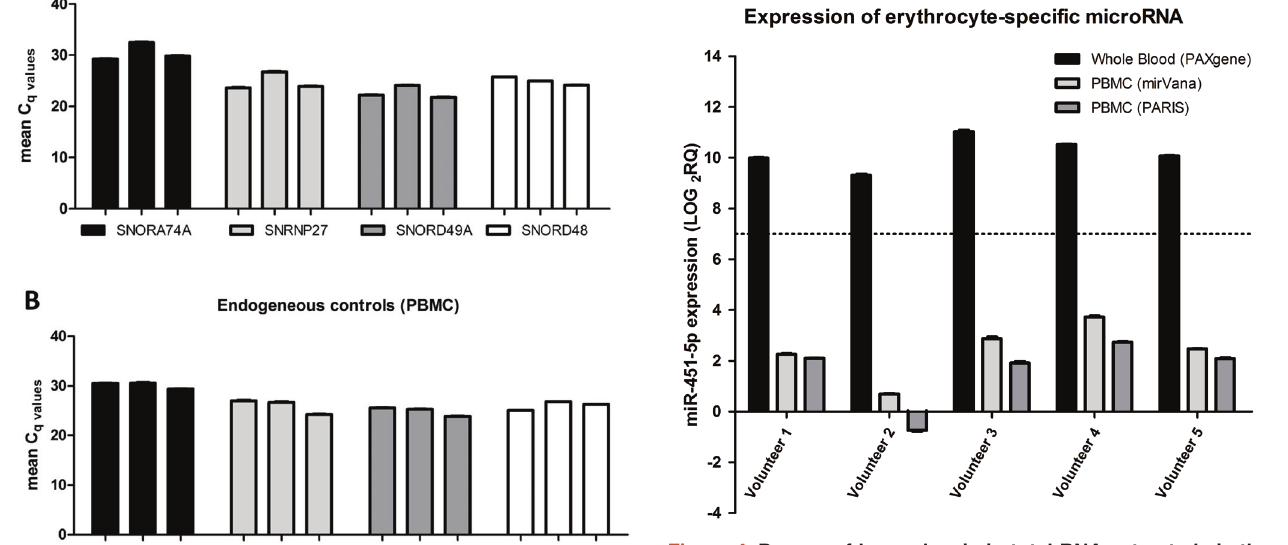
Figure 4. Degree of haemoloysis in total RNA extracted via the three extraction methods. Total RNA extracted using the PAXgene miRNA isolation kit. A threshold of LOG RQ greater than 7 was 2 indicative of haemolysis (dashed line). The degree of haemolysis was calculated by measuring the difference between miR-451-5p and miR-23a-3p expression. All data (n=5) have been log-transformed. The standard error of the mean is shown by the error bars for demonstration of technical